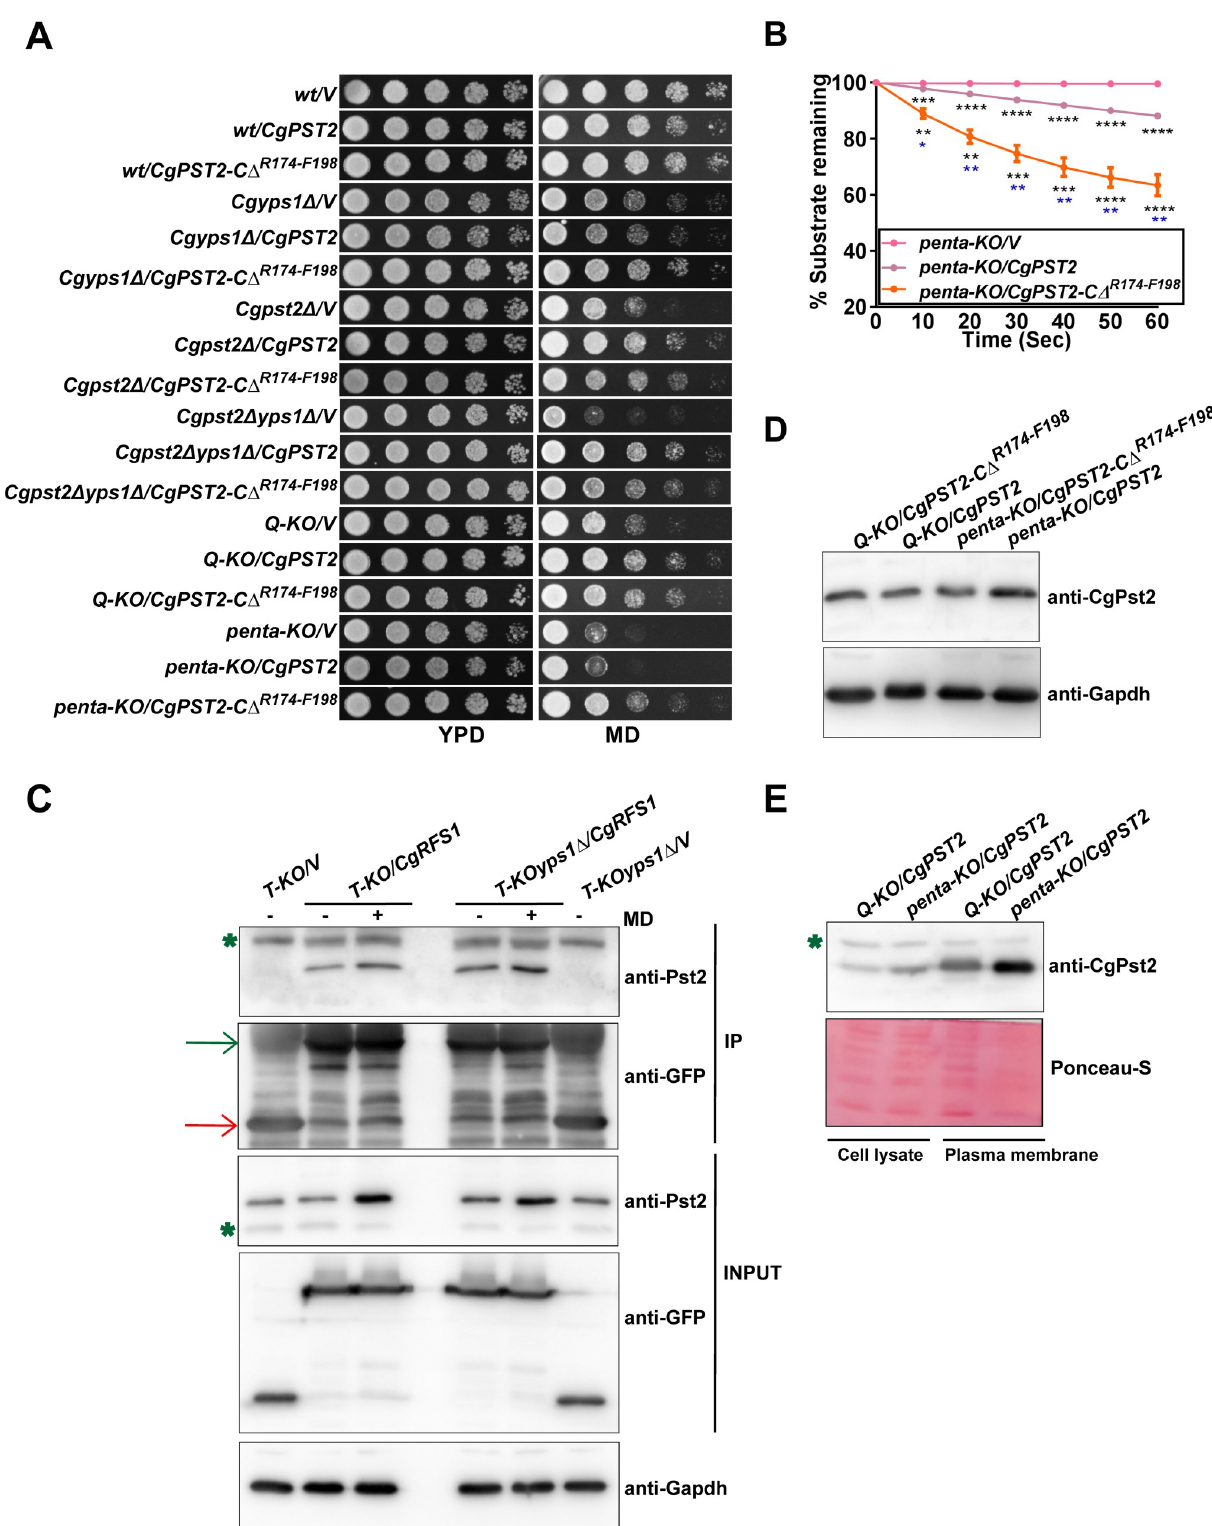
Fig 5. CgPst2- C Δ R174-F198 possesses higher activity than CgPst2 in penta-KO . A. Serial dilution spotting assay showing CgPST2-C Δ R174-F198 -mediated rescue of MD (80 μ M) sensitivity. V, pRK74 vector. The Q-KO strain lacks four flavodoxin-like proteins (Fld-LPs), CgPst2, CgRfs1, CgPst3 and